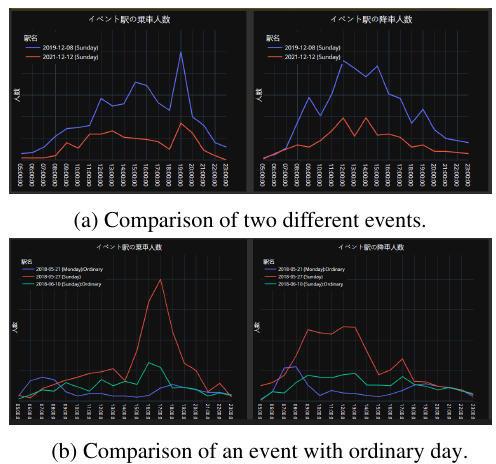
Figure 6. Visualizations in event-comparison module.